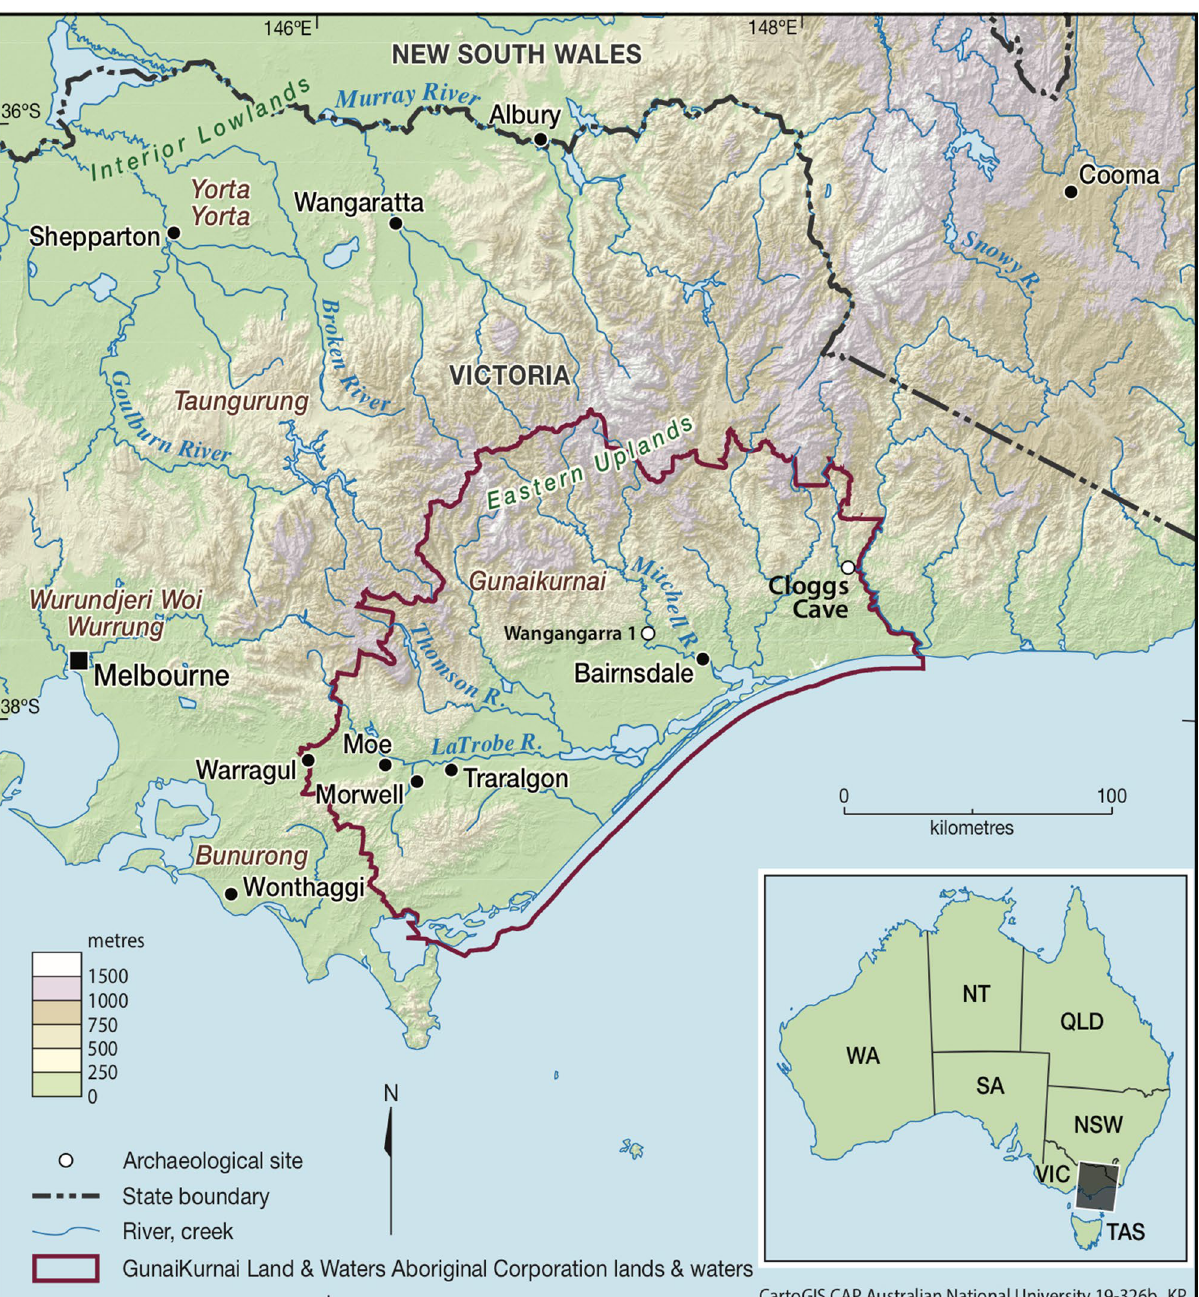
Figure 2. Location of Cloggs Cave and the area of the GunaiKurnai Land and Waters Aboriginal Corporation, at the southern foothills of the Australian Alps. Esri ArcMap 10.5 (https ://deskt op.arcgi s.com/en/arcma p/) and Adobe Illustrator CC 2017 (21.0) (https ://helpx .adobe .com/au/illus trato r/relea se-note/illus trato r-cc-2017-21-0- relea se-notes .html) were used by CartoGIS Services, College of Asia and the Pacific at the Australian National University, to create the